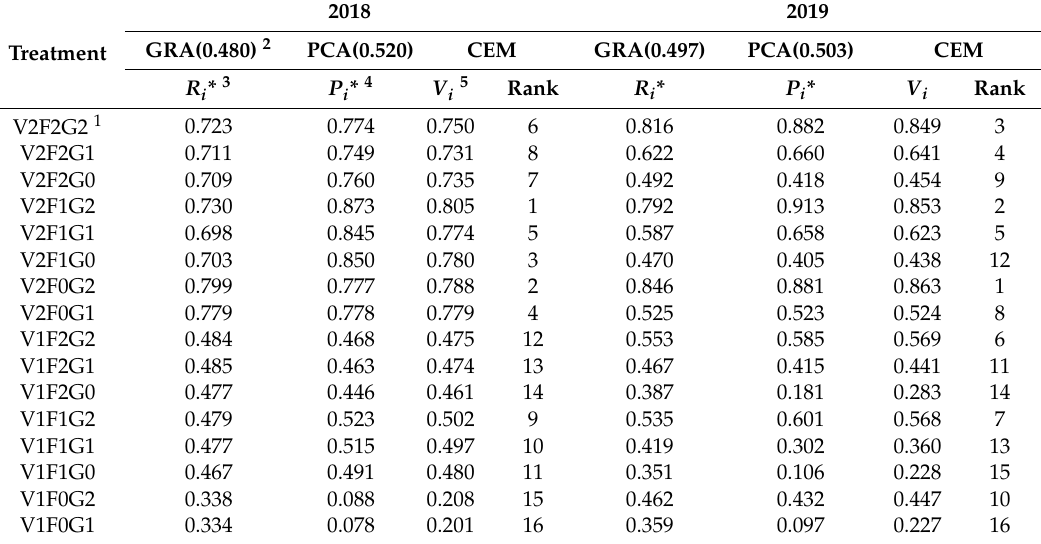
Table 8. Ranks of hybrid maize seed vigor under di ff erent irrigation treatments using principal component analysis (PCA), grey relational analysis (GRA) and combinatorial evaluation method (CEM) in 2018 and